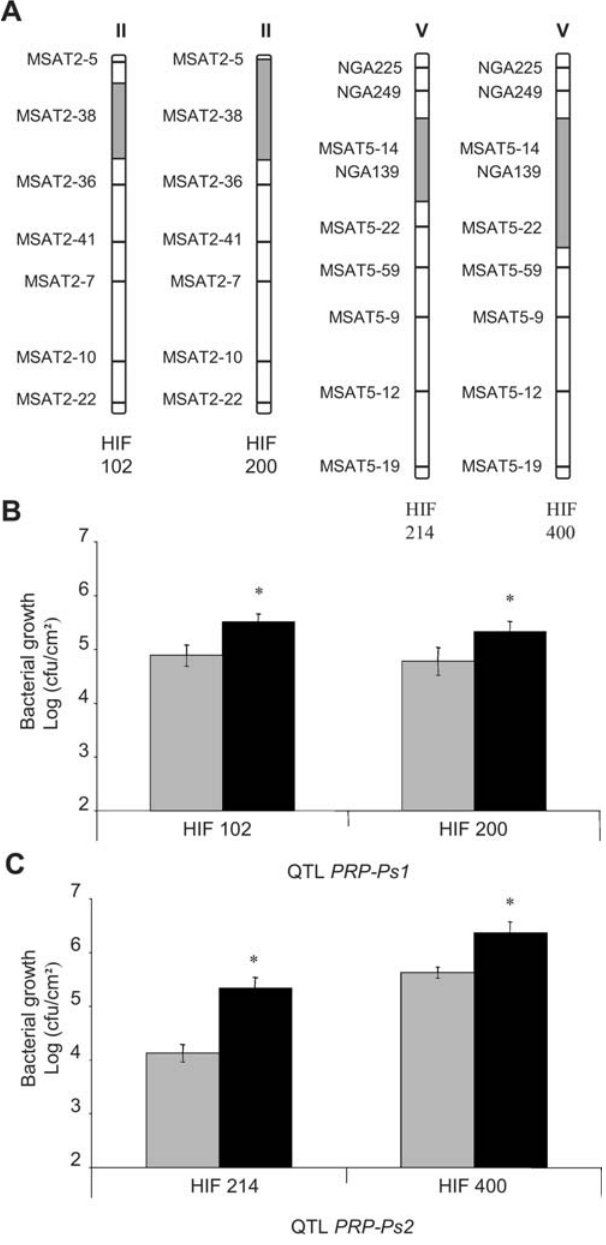
Figure 4. Validation of the major QTLs for partial resistance to Pseudomonas syringae pv. tomato DC3000 with heterogeneous inbred families (HIFs). A HIF 102 segregates around MSAT2-38 and HIF 200 segregates for a region of chromosome II around markers MSAT2-5 and MSAT2-38. HIF 214 segregates for a region of chromosome V around MSAT5-14 and NGA139 and HIF 400 segregates around MSAT5-14, NGA139 and MSAT5-22. Regions for which the HIFs segregate are indicated in hatched boxes and the white regions of the chromosomes represent a mix of both parental genomes Bay-0 and Shahdara. B and C In planta bacterial growth in HIFs fixed for the Bay (grey bar) or Sha (black bar) allele of PRP-Ps1 ( B ) or PRP-Ps2 ( C ). Each value is the average of measurement of in planta bacterial growth in at least 8 plants (means and standard errors) from one experiment. Three independent experiments were performed and showed similar results. Asterisks show significant difference in partial resistance (P , 0.05).